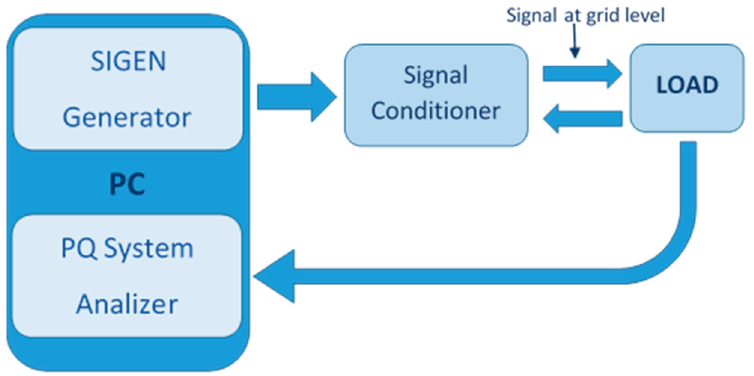
Figure 3. Developed system scheme: Voltage generator with preset disturbances, power amplifier, and signal conditioner, load and Power Quality Analyzer.